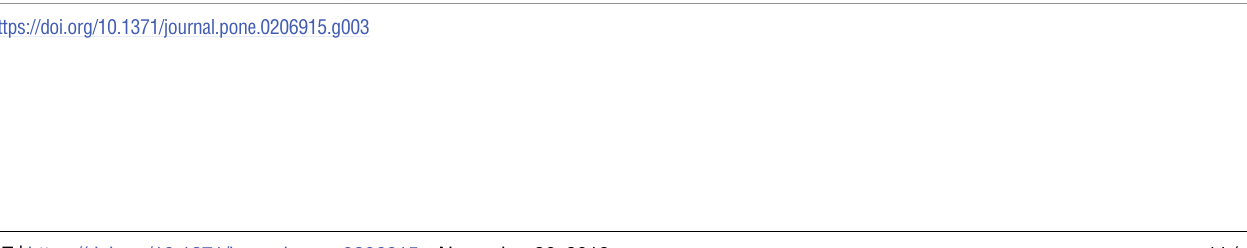
Fig 3. Item characteristic curves showing probability of having a medical condition as a function of amount of medical complexity and patient subgroup. As previously demonstrated in Fig 1; a medical condition in one group may reside at the lower end of the complexity continuum, while in another group, the same condition represents extreme